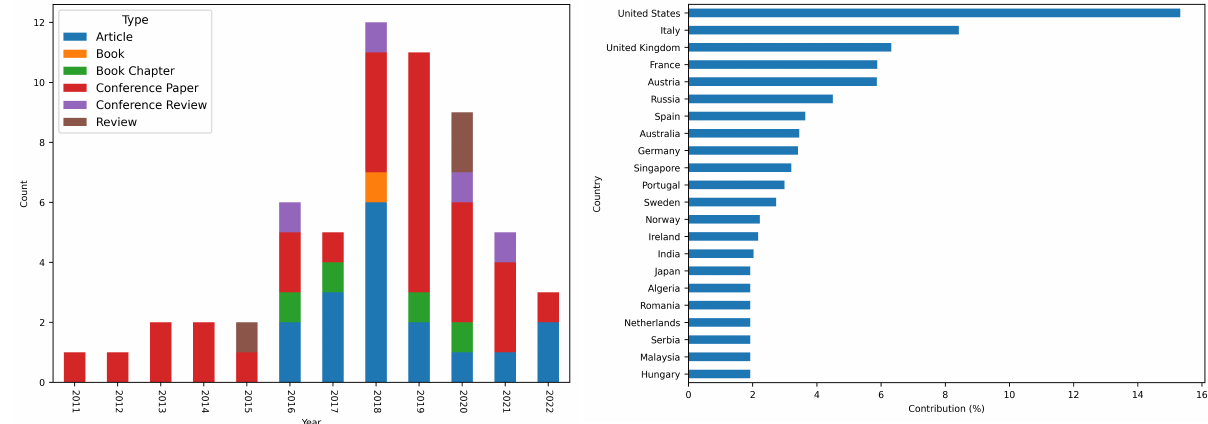
Figure 4. Evolution of papers over time and